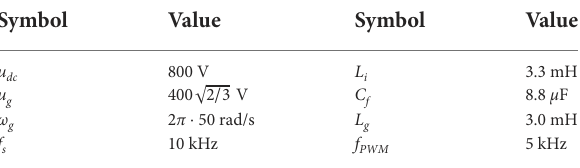
TABLE 1 Simulation system parameters.